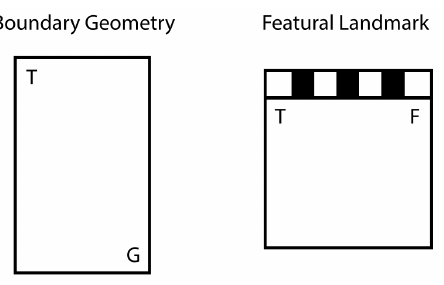
Figure 1. In the boundary geometry condition (left), the use of the rectangular arena geometry in the working-memory task is measured by comparing the total time spent at the target corner (T, which is inaccessible during the test) and its geometrically symmetrical corner (G) to the total time spent at the other two corners. In the reference-memory task, the time spent at G (before the animal finds the accessible T) is compared to the average time spent at the other two corners. As in the above example, if T is a corner with the “long wall on the left”, then G is the other corner with the same geometrical relation. In the featural landmark condition (right), the use of the striped wall in the working-memory task is measured by comparing the total time spent at the target corner (T) and the featurally symmetrical corner (F) to the total time spent at the other two corners. As in the above example, if T is a corner adjacent to the striped wall, then F is the other corner that is adjacent to the striped wall. In the reference-memory task, the time spent at F (before the animal finds the accessible T) is compared to the average time spent at the other two corners.